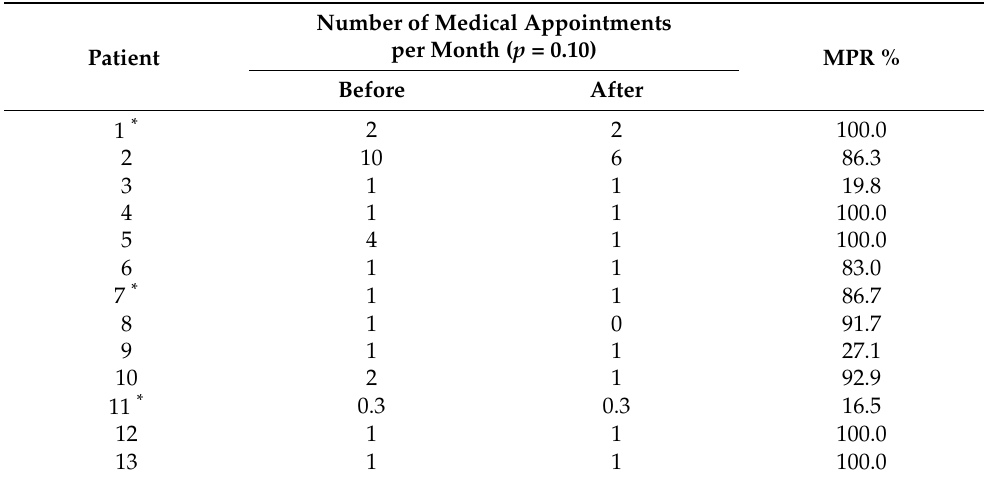
Table 3. Medical appointments per month for each patient before and after using the virtual assistant and MPR values after using the virtual